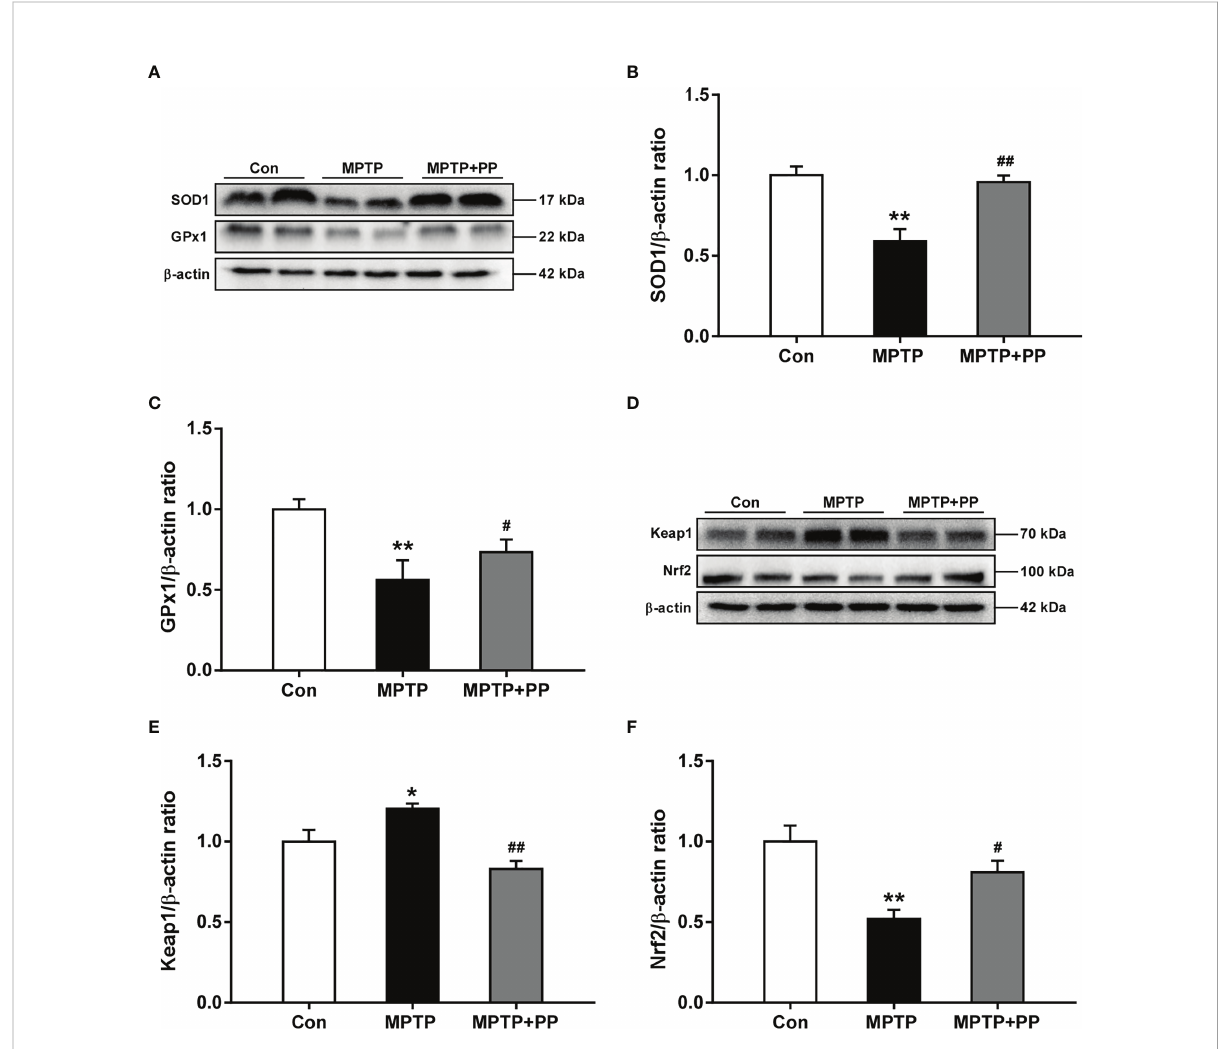
FIGURE 3 Pediococcus pentosaceus treatment improved the methyl-4-phenyl-1,2,3,6-tetrahydropyridine (MPTP)-induced oxidative stress and regulated the levels of Keap1 and Nrf2. (A) Representative western blotting images of SOD1 and GPx1. (B) Quantitative analysis of SOD1. (C) Quantitative analysis of GPx1. (D) Representative western blotting images of Keap1 and Nrf2. (E) Quantitative analysis of Keap1. (F) Quantitative analysis of Nrf2. b -actin was used as internal reference. Statistical comparison by one-way ANOVA with post-hoc comparisons of Dunnett ’ s multiple- comparisons test. Data are presented as means ± SEM; n = 4 – 6 per group. * P < 0.05 vs . Con group, ** P < 0.01 vs . Con group, # P < 0.05 vs . MPTP group, ## P < 0.01 vs . MPTP